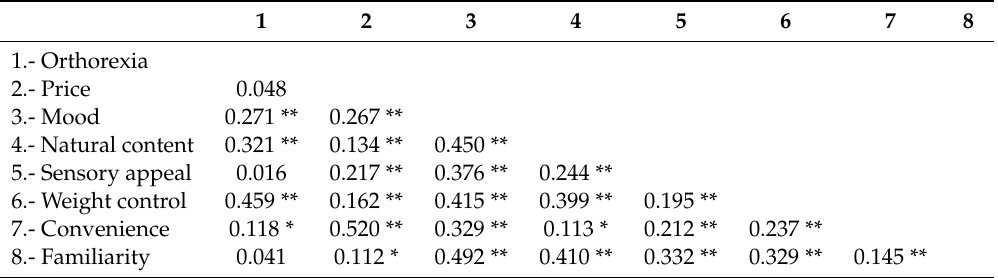
Table 4. Spearman’s correlations between the Spanish version of the ORTO-15 (ORTO-ES-11) and FCQ-SP